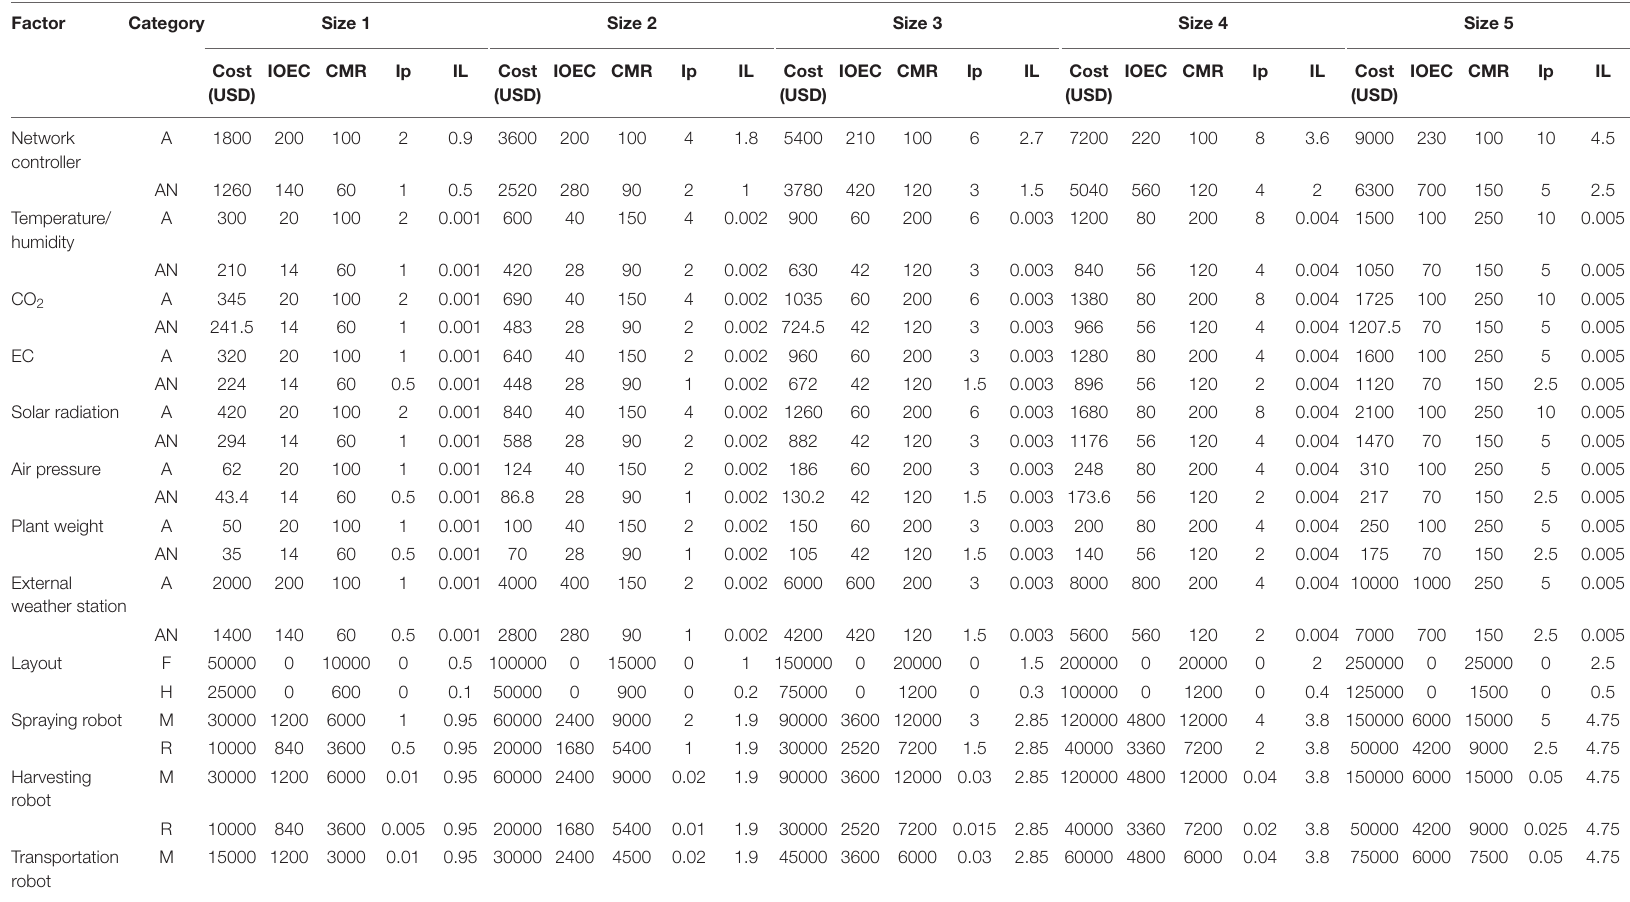
TABLE 2 | Data used in the experimental